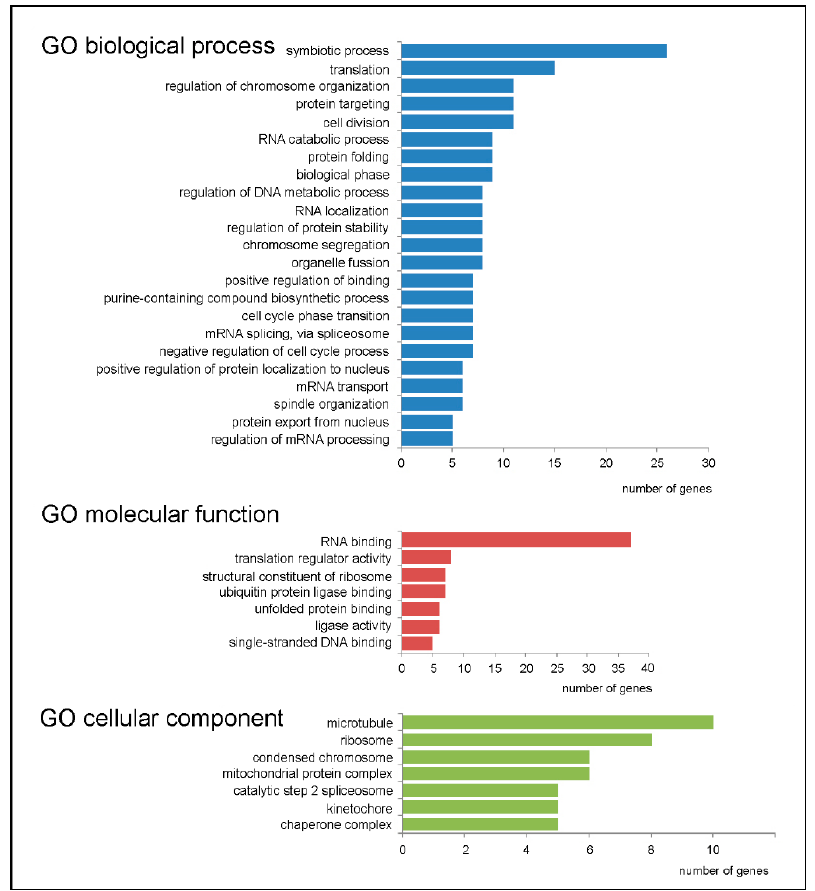
Figure 3. Gene ontology (GO) analysis performed for the up-regulated GDTEs set from HEK293 cells knocked down of eL38. Only the highest categories in the GO hierarchy (biological process, molecular function, and cellular component) with multiple enrichment values >5 and gene numbers of at least 5 are presented.